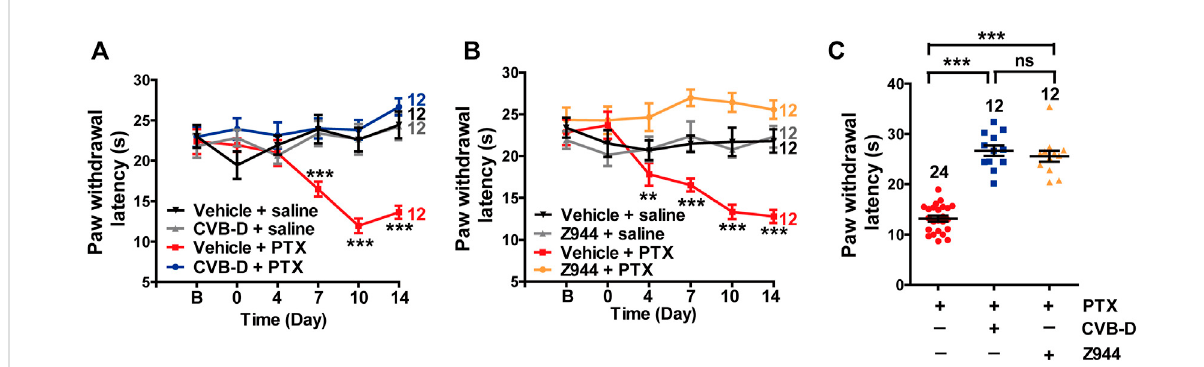
FIGURE 8 Effect of CVB-D on PTX-induced peripheral neuropathy. (A) Effect of CVB-D on PTX-induced thermal hypersensitivity. PWL was measured by the hot plate assay in a 2-week period. Vehicle-saline (black) was used as a control for vehicle-PTX (red), and CVB-D-saline (gray) was used as a control for CVB-D-PTX (blue). Statistical analysis was performed between the groups of CVB-D-PTX (blue) and Vehicle-PTX (red). (B) Effect of Z944 on PTX-induced thermal hypersensitivity. Same experimental procedures as in A, except that the mice received i. pl. injection of Z944 30 minpriortotreatmentwithPTX.Vehicle-saline(black)wasusedasacontrolforvehicle-PTX(red),andZ944-saline(gray)wasusedasacontrolfor Z944-PTX (orange). Statistical analysis was performed between the groups of Z944-PTX (orange) and Vehicle-PTX (red). (C) Comparison of the analgesic effect of CVB-D and Z944 on PTX-induced thermal hypersensitivity on day 14. Data information: Statistical signi fi cance was evaluated using two-tailed t -test (for two-group comparisons) or one-way analysis of variance (ANOVA) followed by Tukey ’ s and LSD test (for multi-group comparisons), with * p < 0.05, ** p < 0.01, and *** p < 0.001; ns indicates no signi fi cance. The exact t, F, and p -values are indicated in Appendix Table S1. All the data are presented as mean ±